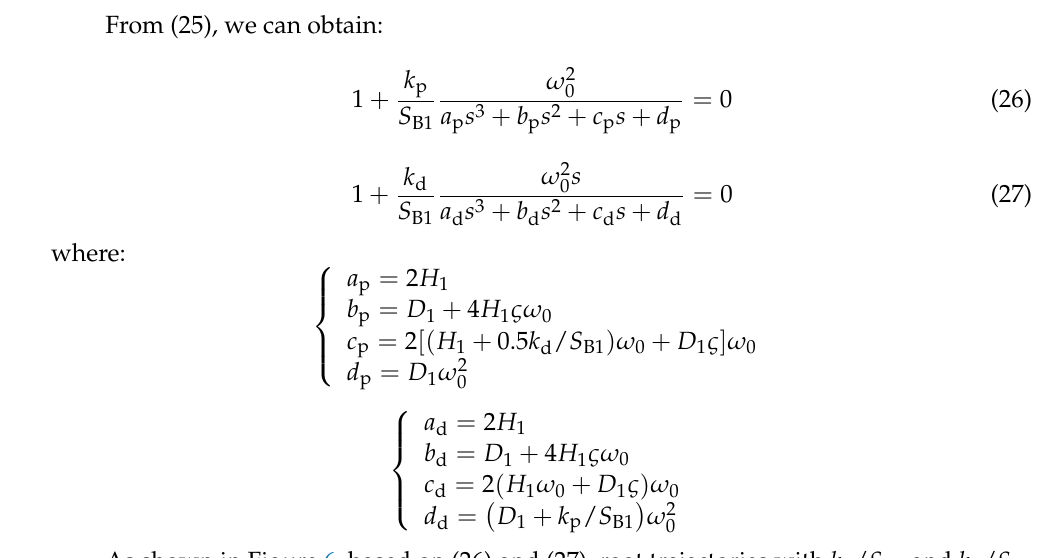
+ − Figure 7. Block diagram of interconnected power system via UHVDC. According to Figure 7, the closed-loop characteristic equation for the interconnected power system via UHVDC can be obtained as: HP_1 RH_1